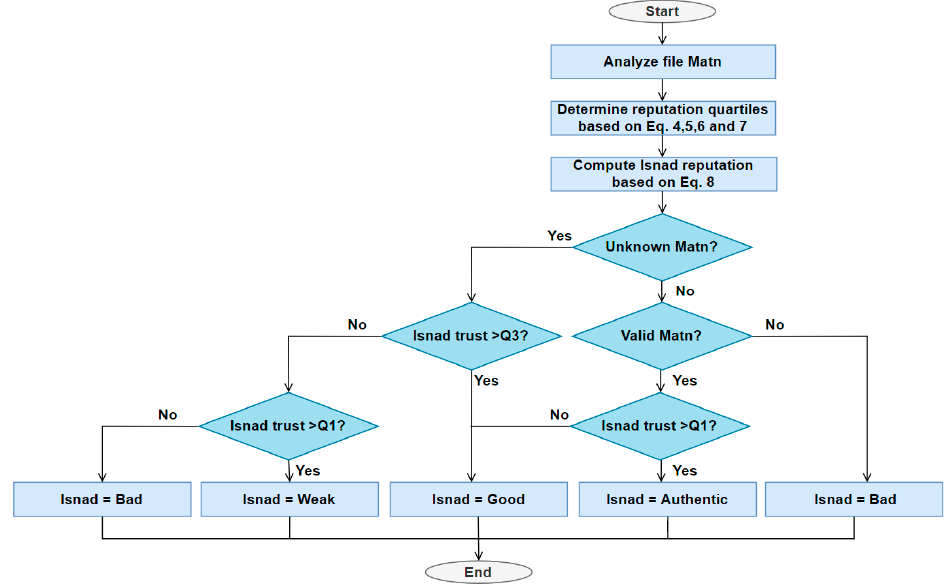
Figure 10. Isnad analysis algorithm flowchart.